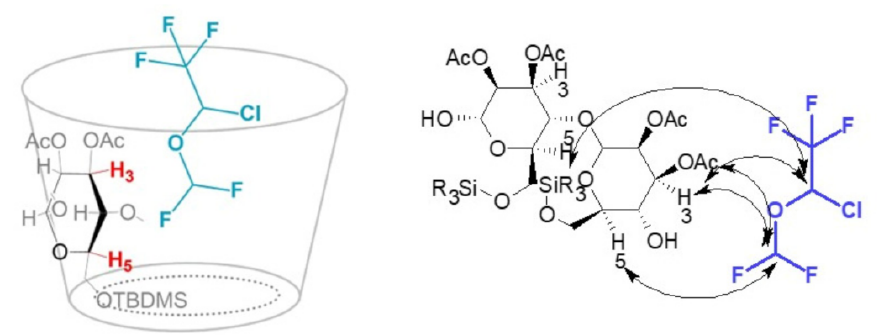
Figure 5. Schematic interaction mechanism between ISO and AcSi γ CD ( left ) and representation of the dipolar interactions (indicated by the arrows) detected via ROESY measurements between ISO and the host ( right